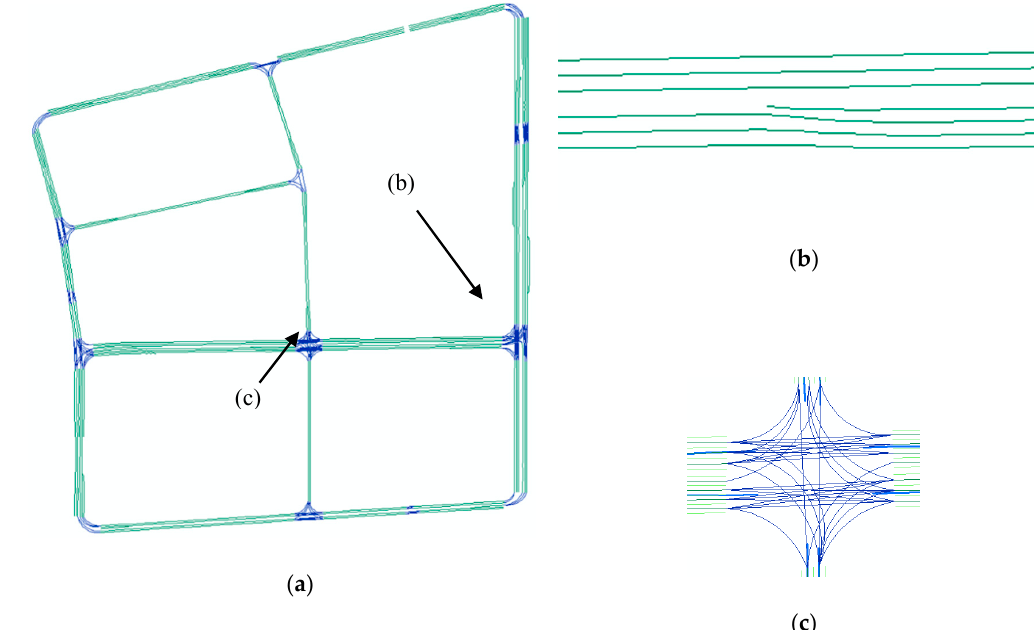
Figure 10. Generation of lane-level road network results: ( a ) Lane-level road network generation results; ( b ) enlarged road network segments; and ( c ) enlarged map of intersection.